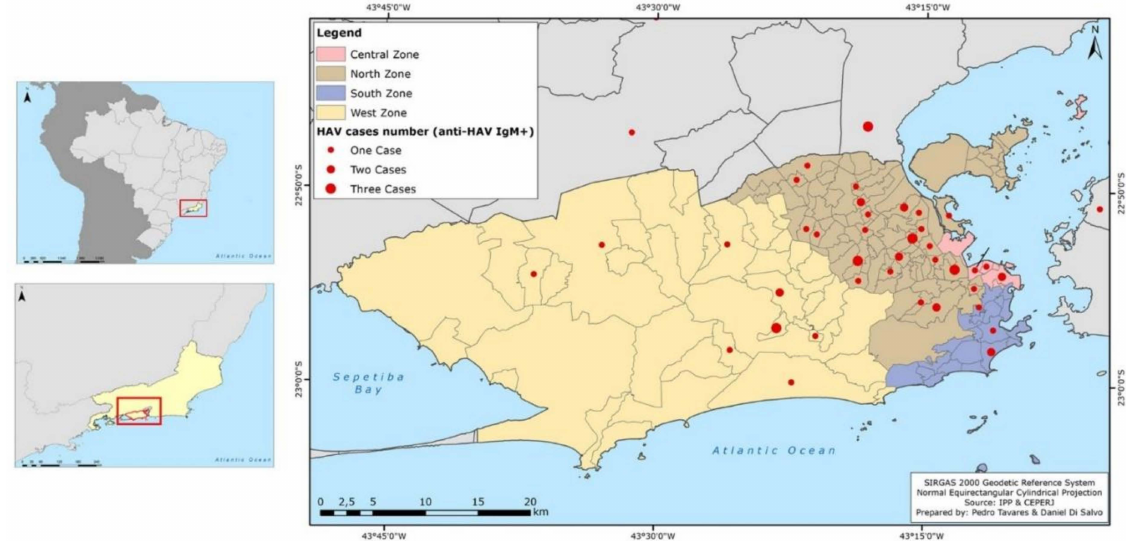
Figure 3. Distribution map of HAV cases (anti-IgM reagent) according to city/neighborhood /geographical zone of residence of patients attended at the clinic. Geographical zones are col- ored; North zone (brown); Central zone (light pink); South zone (blue); West zone (yellow), and neighboring cities (grey). The red dots ( • ) represent cases in each zone/neighborhood: small red dots represent one case, medium red dots two cases, and big red dots three cases. All information can be seen in the legend on the top